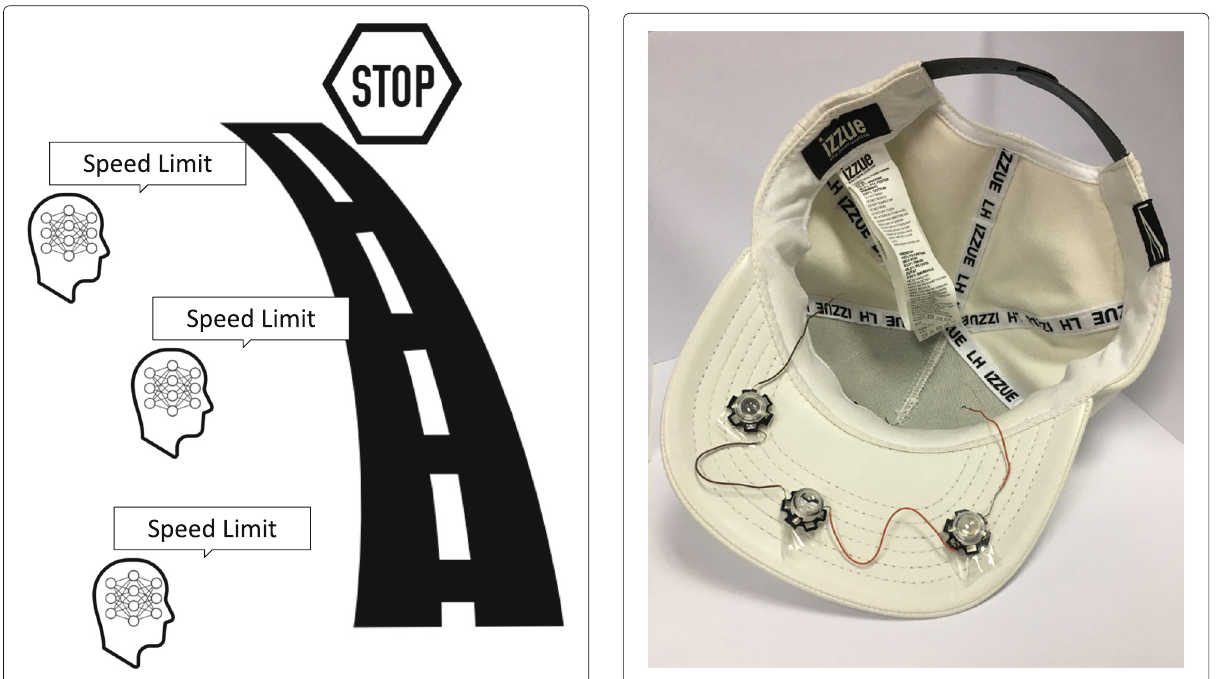
peak, which can light the attacker’s face with some dots from the perspective of cameras, but cannot be noticed by nearby people. With this technique, they successfully attacked face authentication system in a white box setting. Different from previous two works, they didn’t directly optimize perturbation. they built a model describing the infrared dot produced by LED lights with positions, radius and brightnesses as parameters. Therefore, optimizers can optimize over the parameters to precisely search pertur- bations close to real infrared dots.